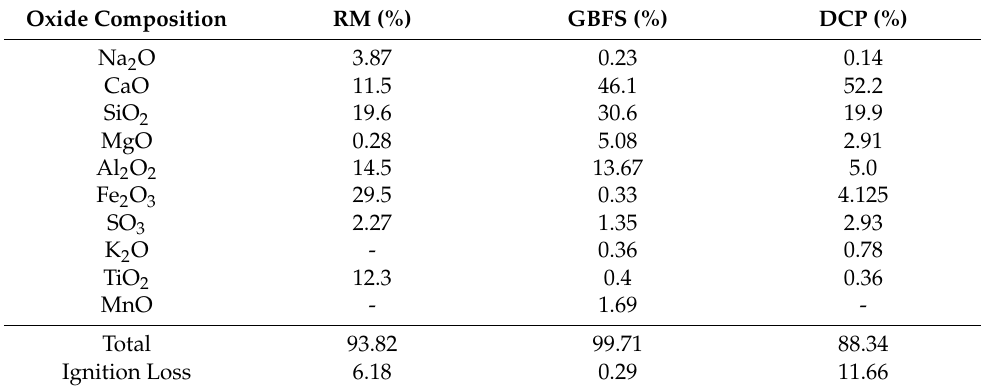
Table 1. Chemical composition of GBFS and